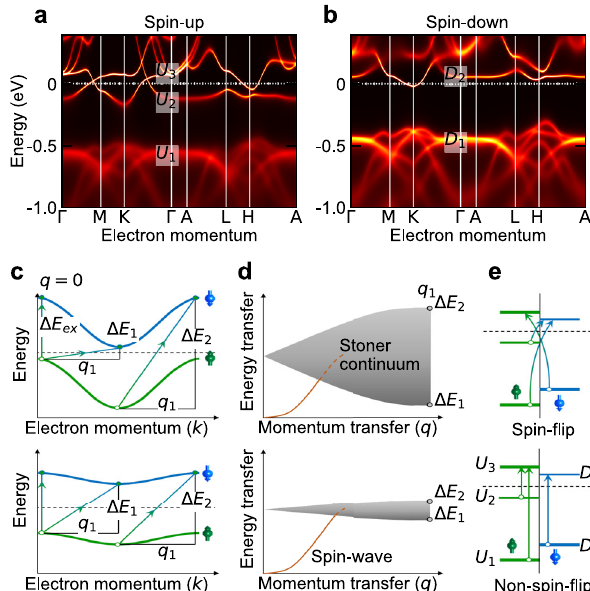
Fig. 2 | Flat band Stoner excitations in Co 3 Sn 2 S 2 . Calculated spin-resolved elec- tronicbandsinCo 3 Sn 2 S 2 fortheFMstatewith( a )spin-upand( b )spin-downbands. c Schematic representation of electronic bands and spin- fl ip Stoner excitations comprising of electron – hole pairs of opposite spins, shown for zero ( Δ k = q =0) and non-zero ( Δ k = q 1 ≠ 0) momentum transfer values. For a rigid band splitting, q =0 excitations have an energy equal to the exchange splitting as seen in ( c ). For non-zerovaluesof q ,excitationpathwayswithdifferentenergiesaresatis fi edgiving rise to a continuum of excitations called the Stoner continuum spread across the ≫ Δ E E − q -space ( Δ E 2 1 ). d Stoner continuum of excitations corresponding to the electronic bands shown in ( c ). As the bands become fl atter or dispersionless, the range of energies for these pathways reduces giving rise to a narrower band of excitations ( Δ E 2 ≃ Δ E 1 ). e , Schematic spin- fl ip and non-spin- fl ip q =0 excitations close to Γ , from and to the points marked in ( a , b